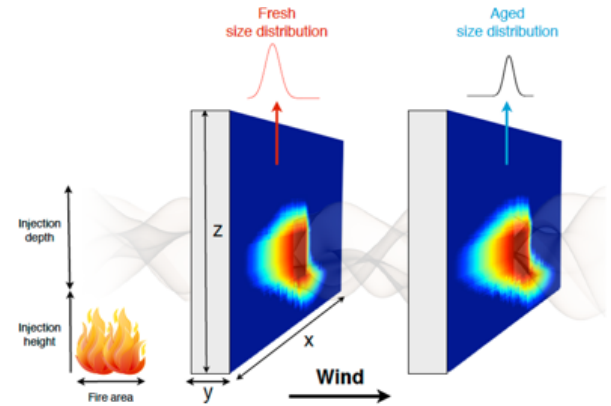
Figure 1. Schematic of the 2D Lagrangian wall configuration of SAM-TOMAS and SAM-ASP v1.0. Reproduced from Sakamoto et al.